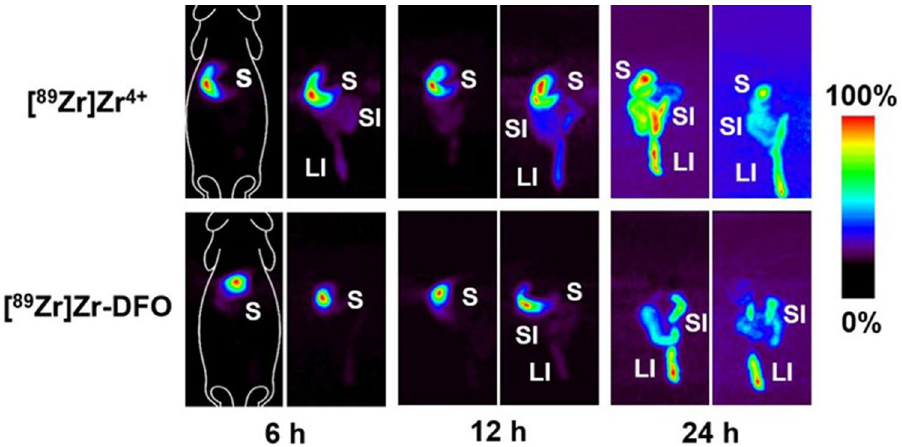
Figure 4. MIP PET images of control mice that received 1.85 MBq (50 µCi) of [ 89 Zr]Zr 4+ or [ 89 Zr]Zr-DFO per os. Two mice from each cohort are shown (n = 4). S = stomach. SI = small intestine. LI = large intestine.